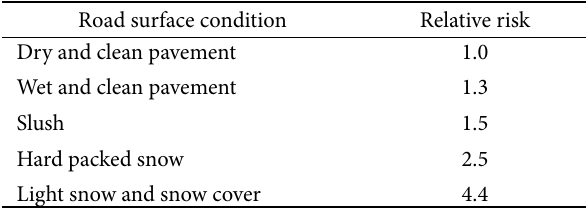
Table 2. Accident risk depending on road surface condition Road surface